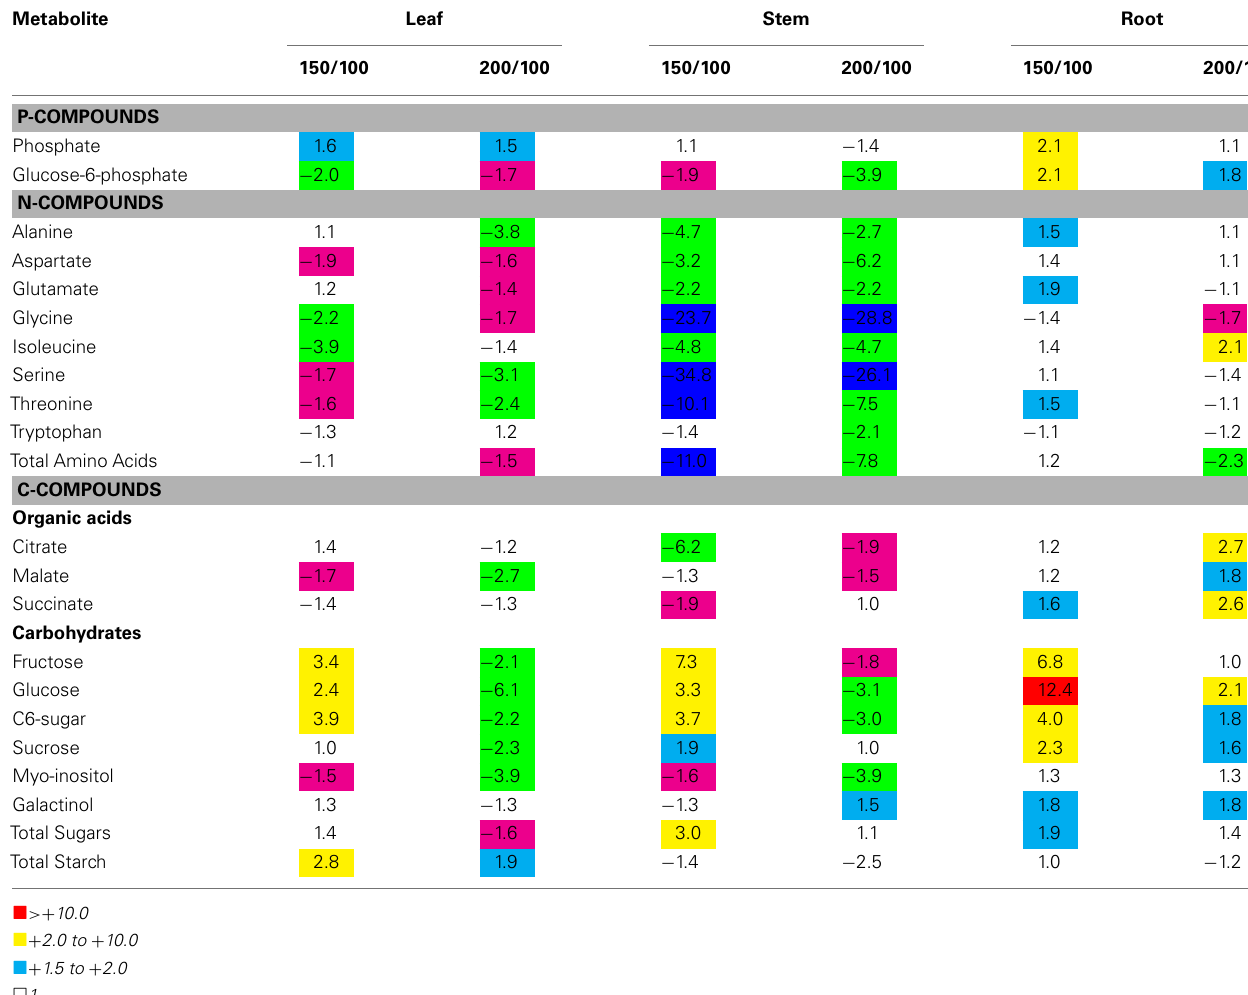
Table 1 | Relative quantification of the different metabolites detected in the three maize Genotypes growing under nitrogen limitation.